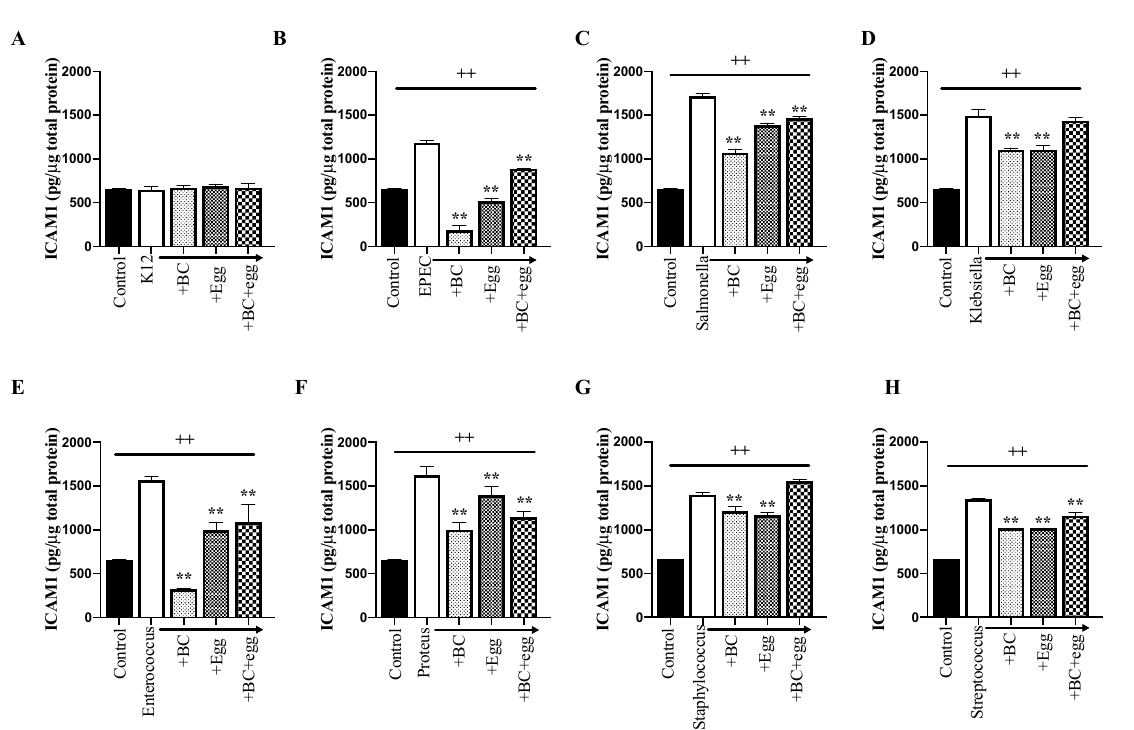
Figure 5. Effect of BC, egg, or the combination on ICAM-1. Bacterial strains (1 × 10 6 CFU/well) ± BC (1 mg/mL), egg (1 mg/mL), or the combination (0.6 mg/mL BC + 0.4 mg/mL egg) were added to confluent monolayers of Caco-2 cells. Cleared lysates were prepared 24 h later. Control wells received no bacteria or test product. ( A ) E. coli K12 (negative control); ( B ) EPEC; ( C ) Salmonella ; ( D ) Klebsiella ; ( E ) Enterococcus ; ( F ) Proteus ; ( G ) Staphylococcus ; ( H ) Streptococcus. Results are expressed as mean ± SEM from 3 wells. ++ signifies p < 0.01 vs. non treated (without bacteria or test product) control and ** signifies p < 0.01 vs. bacteria